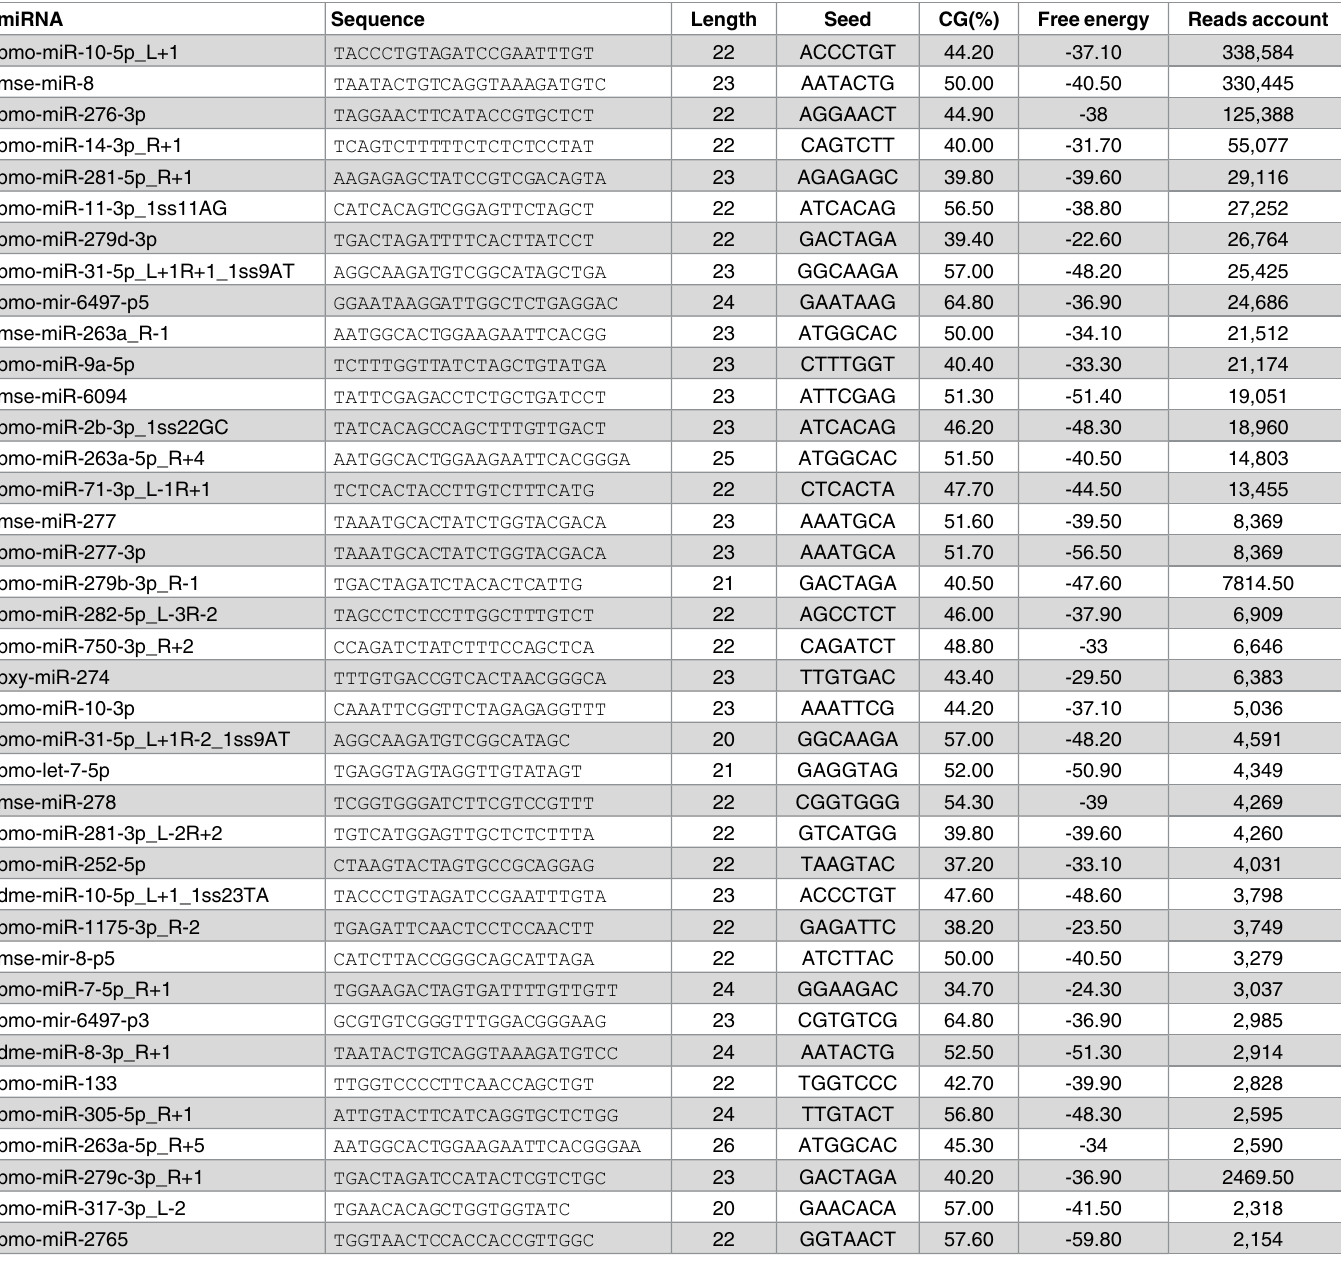
Table 2. The most abundant conserved miRNAs in the sRNA library of G . molesta